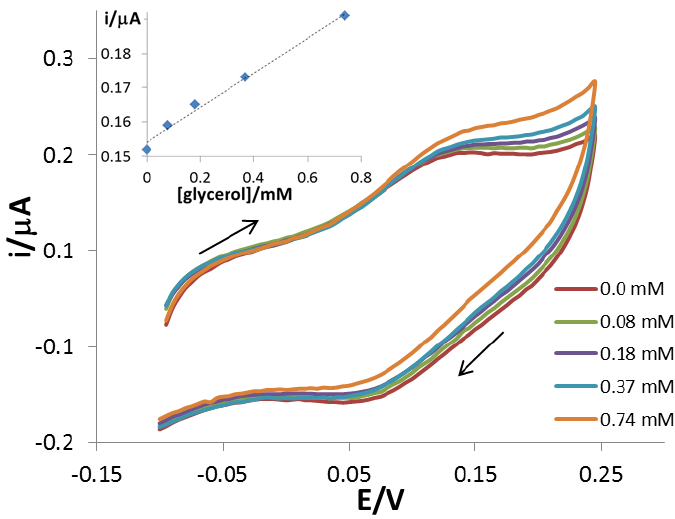
Figure 5. CV responses of glycerol dehydrogenase enzyme (GDH)/CFA ads /CB/SPEs in 0.1 M PB (pH 8.0), 0.1 KCl, 2 mM NAD + in the absence and in the presence of glycerol